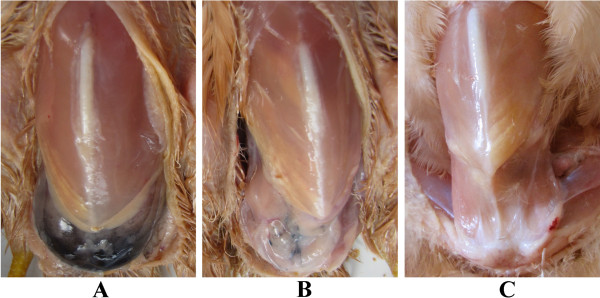
Classification of the hyperpigmentation of visceral peritoneum. A, B, and C represent severe, mild, and absent hyperpigmentation of the visceral peritoneum, respectively.